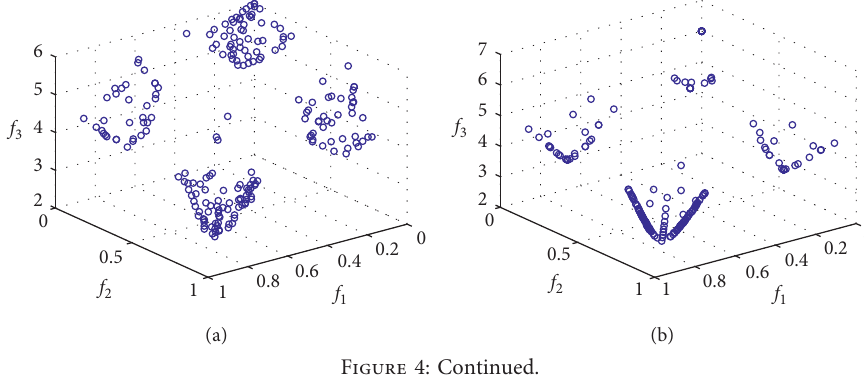
0 0.2 0.4 0.6 0.8 Figure 4: